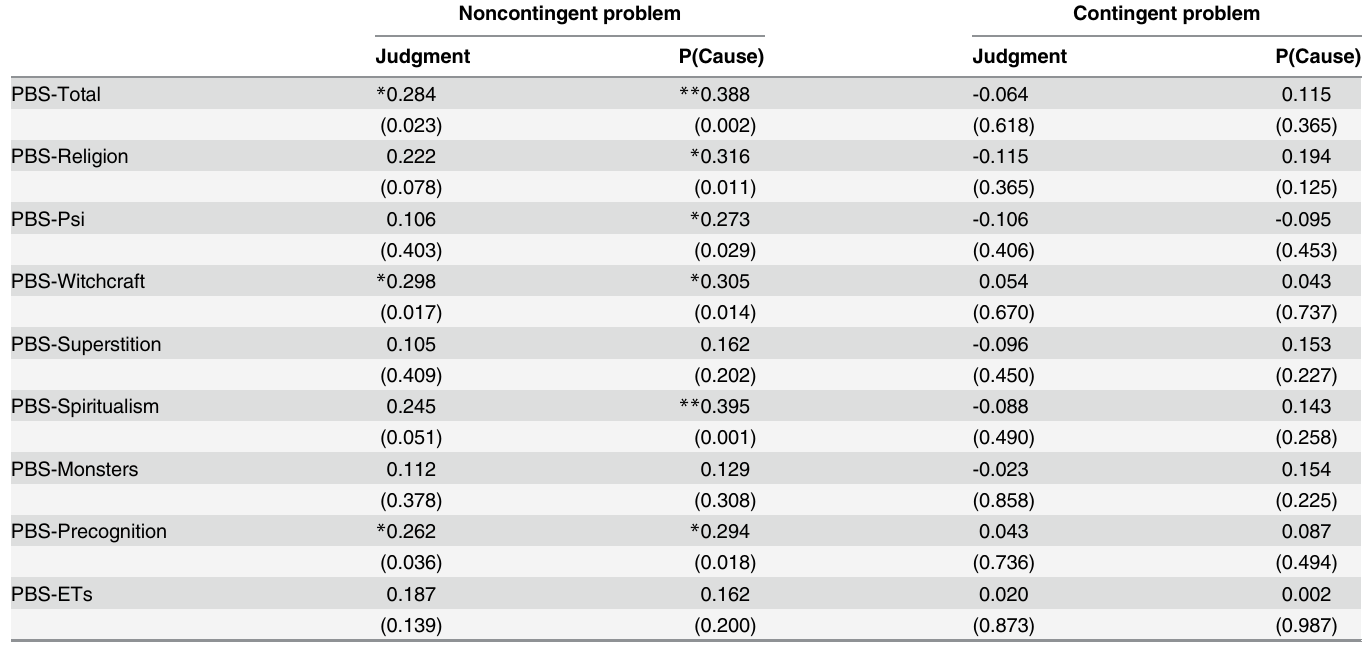
Table 1. Observed correlations between the variables assessed in the two contingency learning problems (columns) and the paranormal belief scores